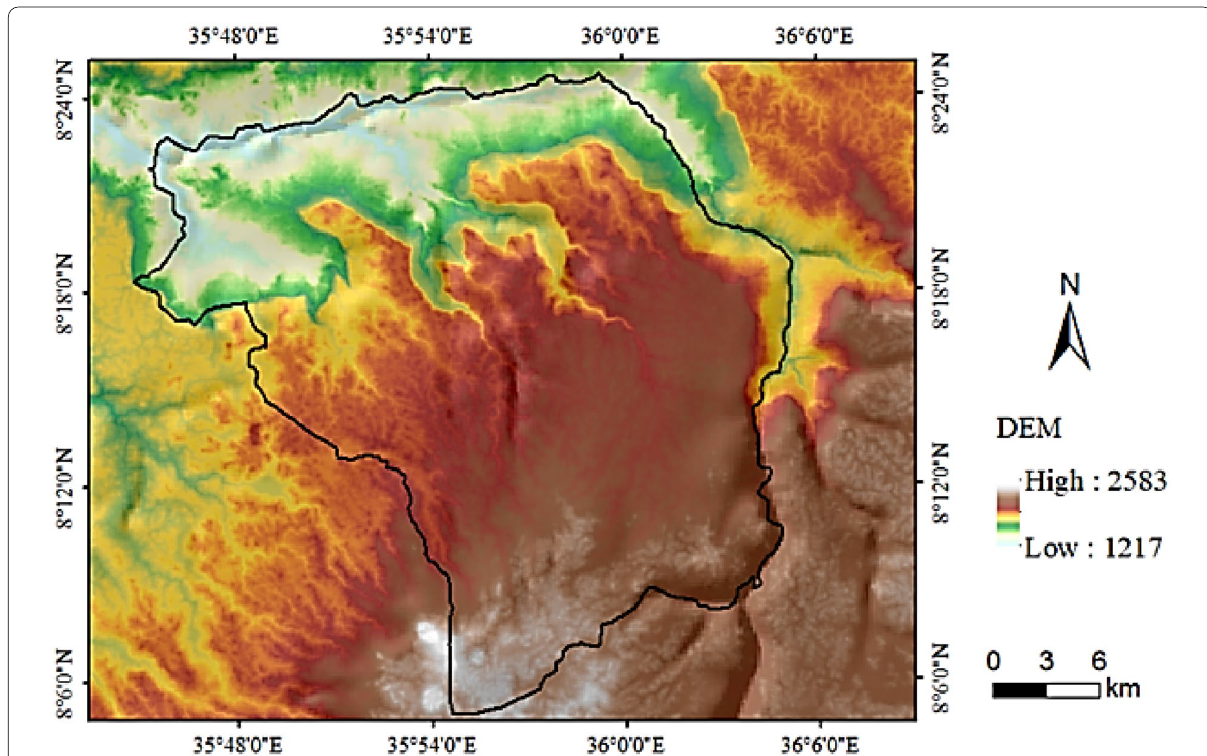
Fig. 2 Digital elevation model (DEM) map of the Yayu forest showing the highest and lowest elevation points in the study